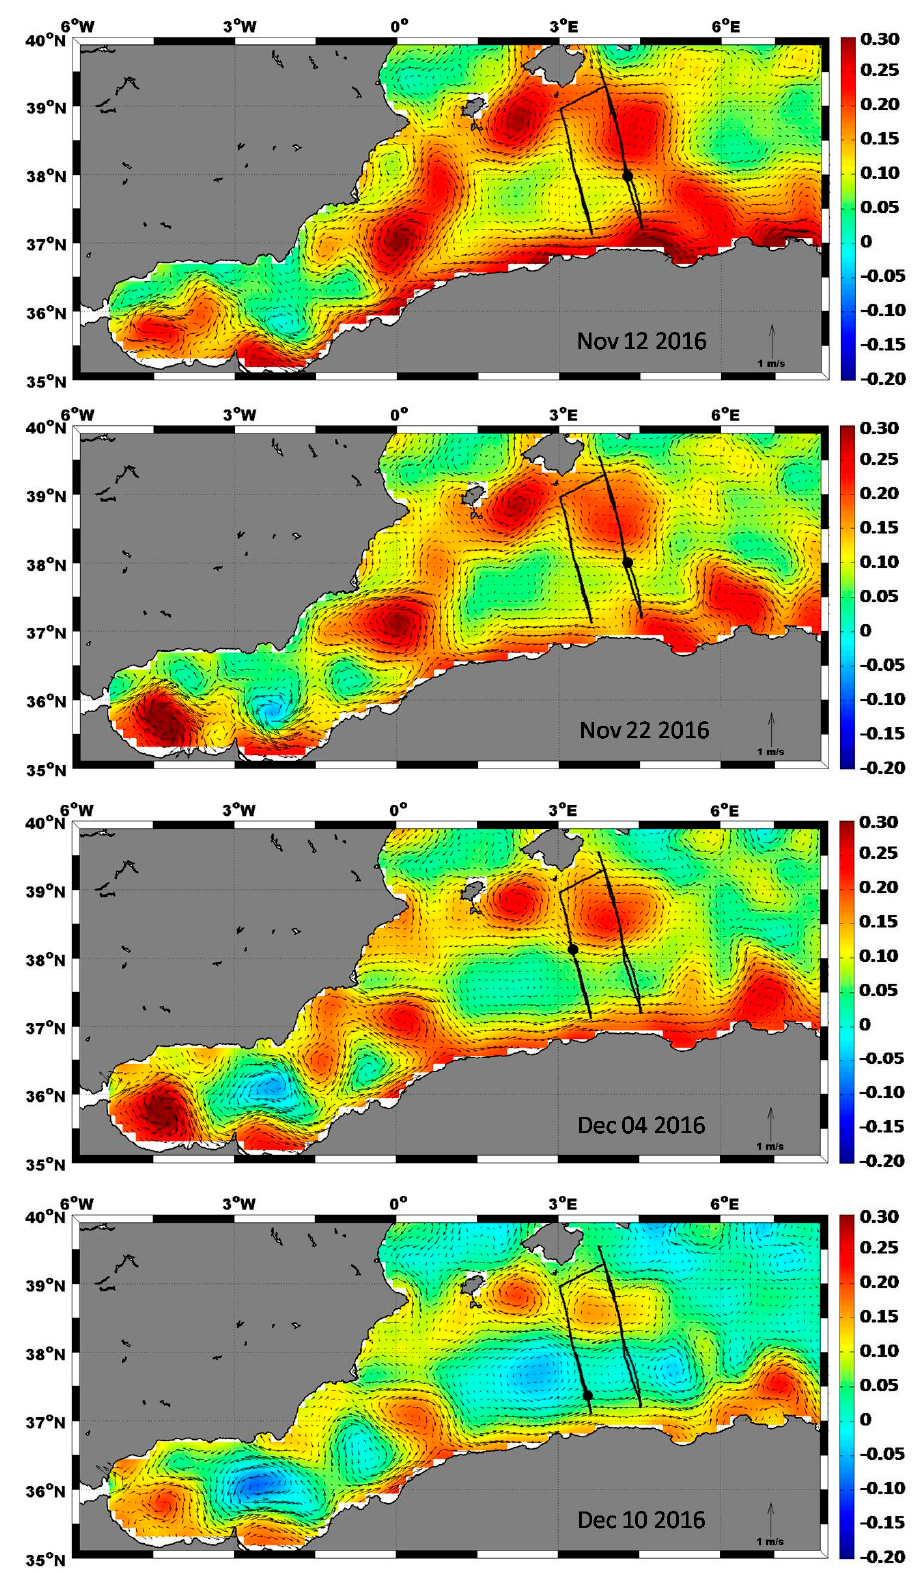
Figure 15. All-sat-merged AVISO ADT maps of the Alboran Sea and the Algerian Basin on four representative dates of the ABACUS 3 survey. Glider track in black. Large black dots represent glider location on each date. Geostrophic currents are represented through black arrows. ADT in meters.